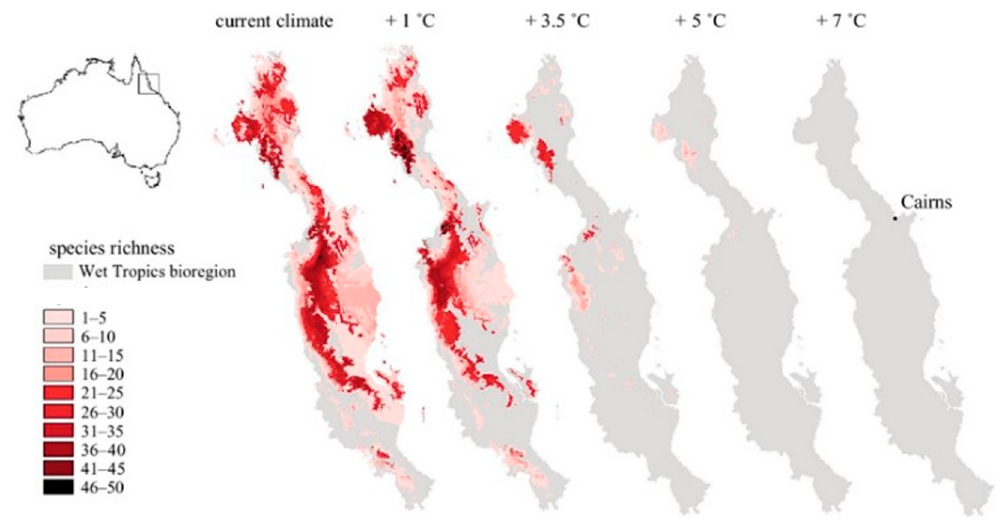
Figure 5. Geographical pattern of species richness of regionally endemic rainforest vertebrates at each temperature scenario. Species richness is produced by overlaying all species-distribution models at each temperature scenario [25].